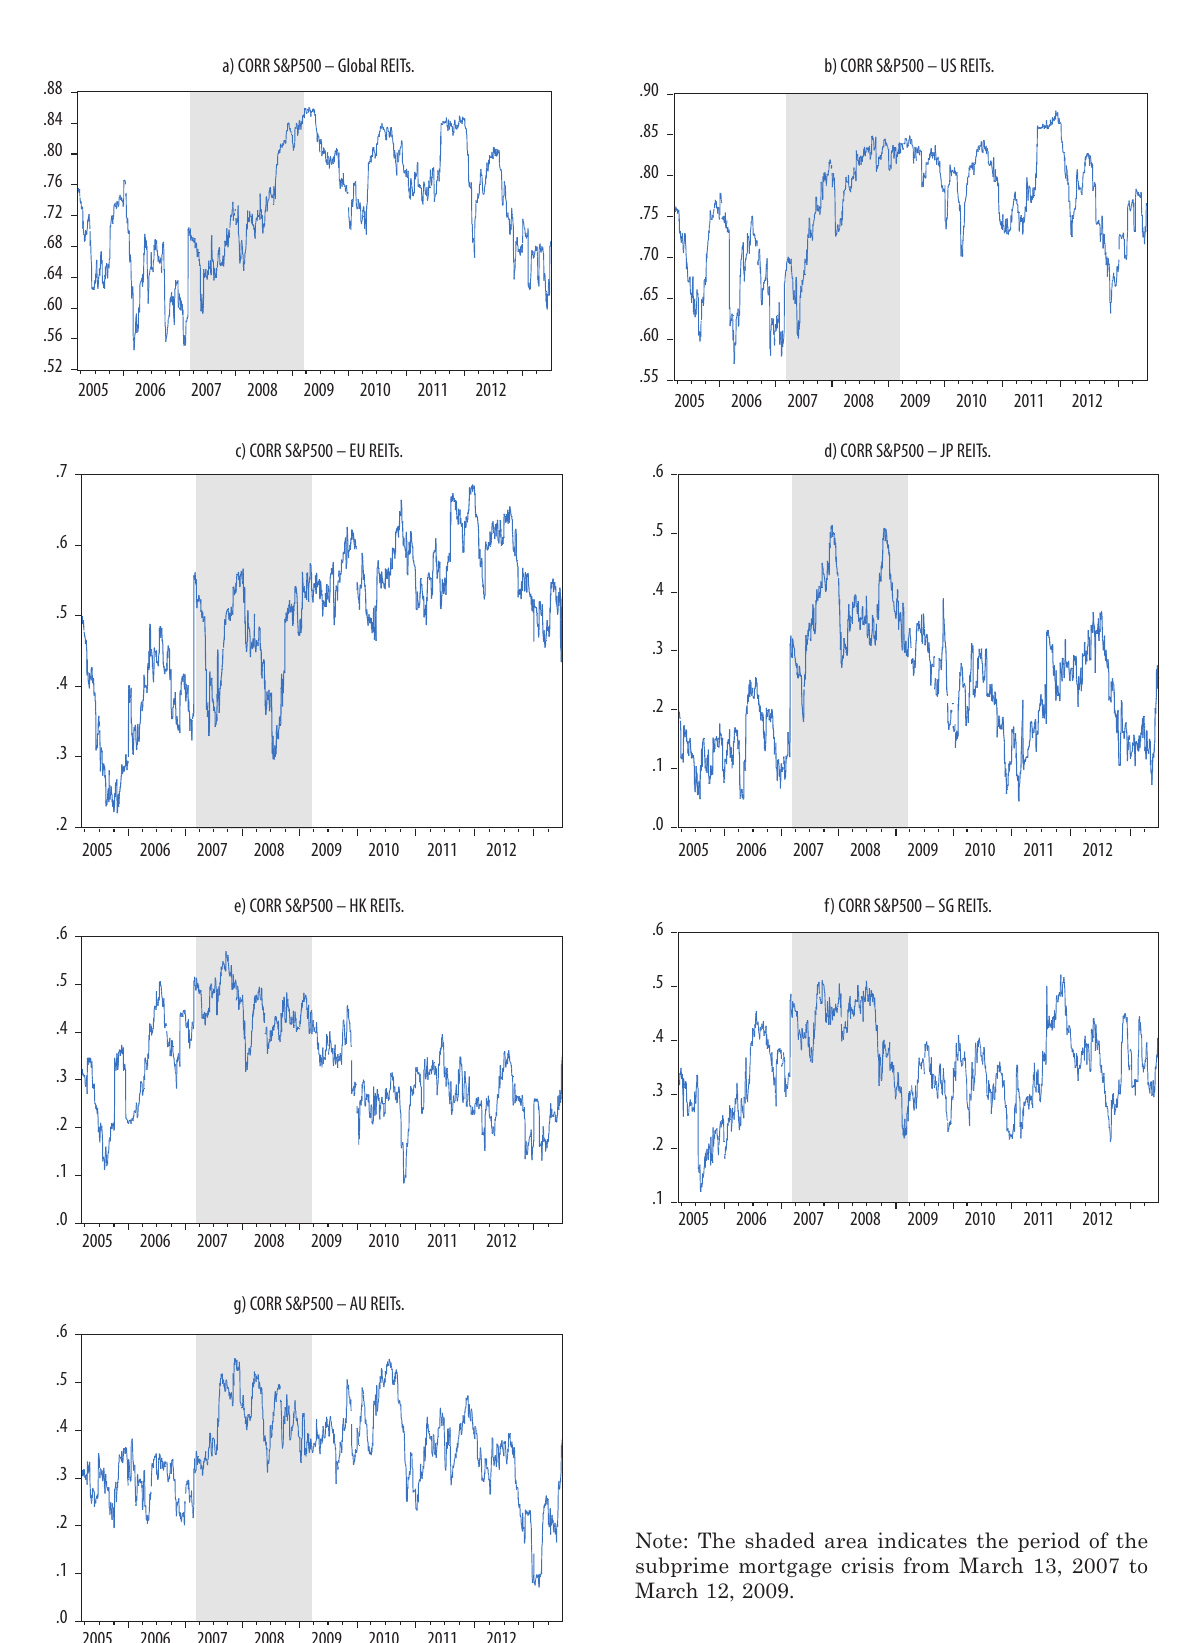
Fig. 2. The DCCs between the S&P 500 and each REIT